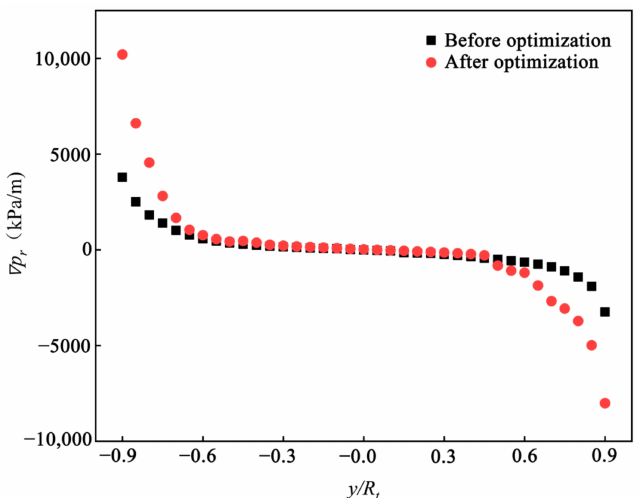
Figure 9. Internal radial pressure gradient before and after optimization (at inlet section of